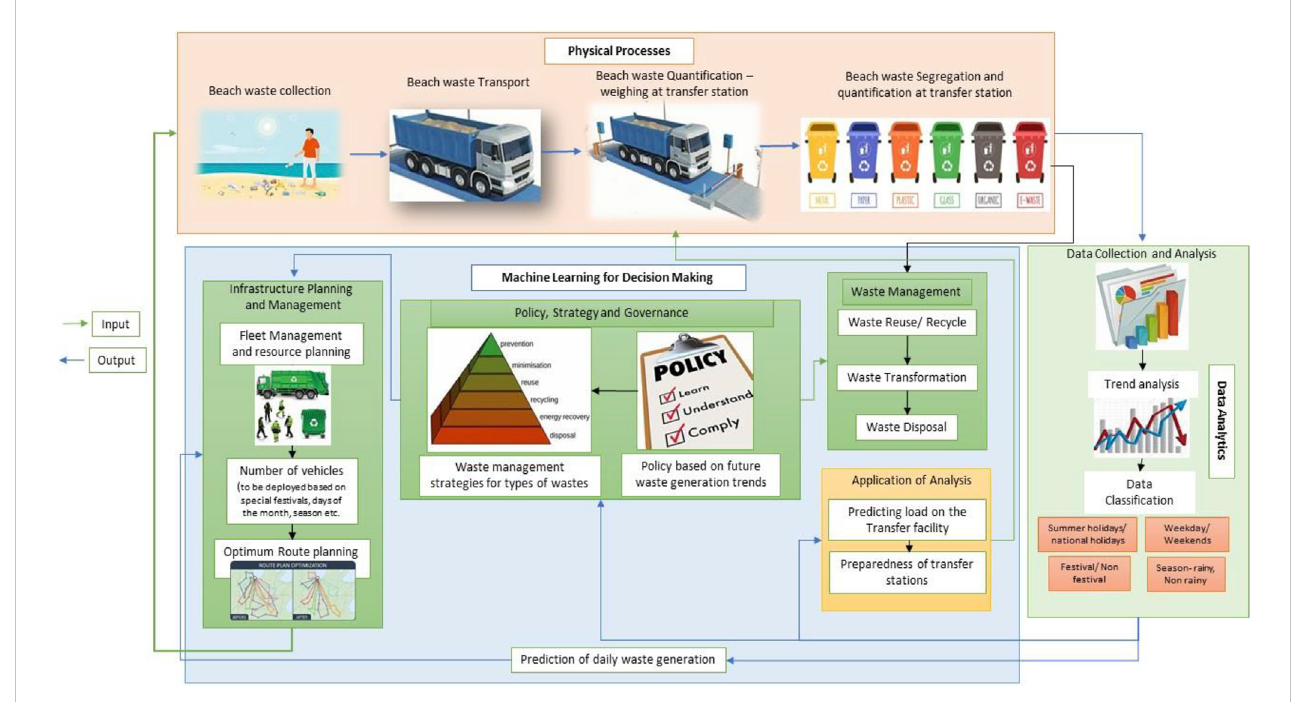
FIGURE 12 Machine Learning based automated Beach Waste Management System